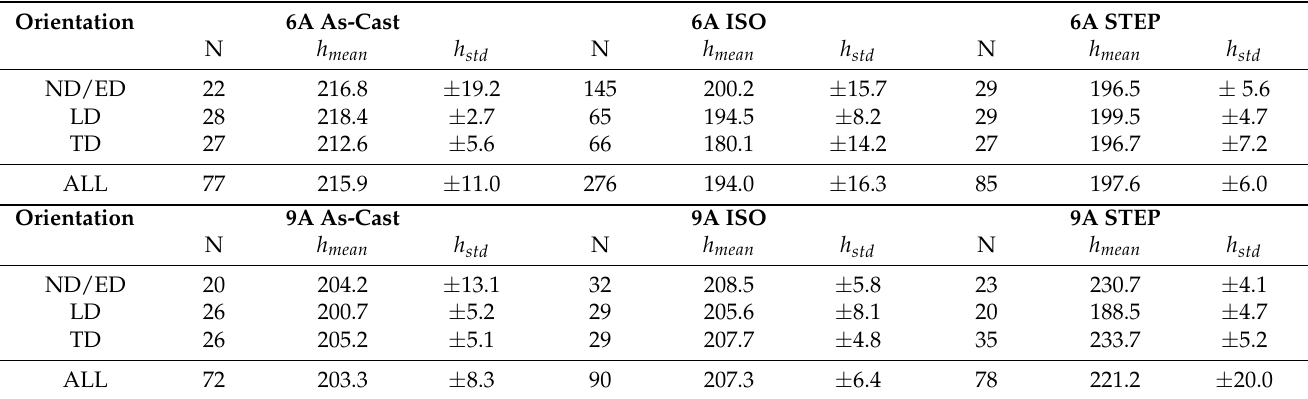
Table A1. Sample population and thickness information. The orientation-specific and sample-specific total sample sizes and thickness means, h mean , and standard deviations, h std , for all of the experiments presented. All thickness measurements are expressed in units of µ m.